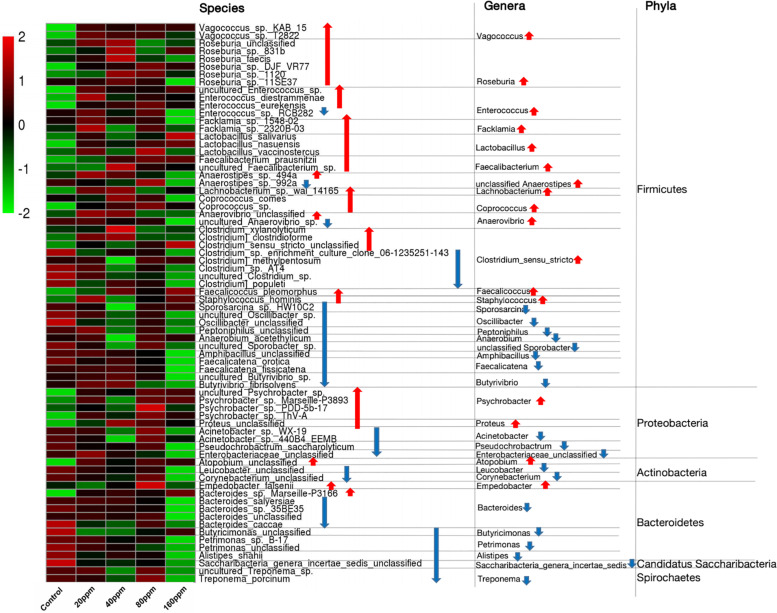
Shifts in the ileum bacterial compositions. Heat map and hierarchical clustering of differentially abundant gut bacterial in piglets with different ε-polylysine supplement level (0, 20, 40, 80, 160 ppm). The values of color in the heat map represent the normalized relative abundances of species (Log 10). Detailed data for heat map were shown in the Supplementary Data 4. Statistics were conducted by ANOVA with Tukey-Kramer test and Benjamini-Hochberg correction among five groups (n = 5), and the P-value lower than 0.05. Detailed data for the heat map were shown in the Supplementary Data 4.